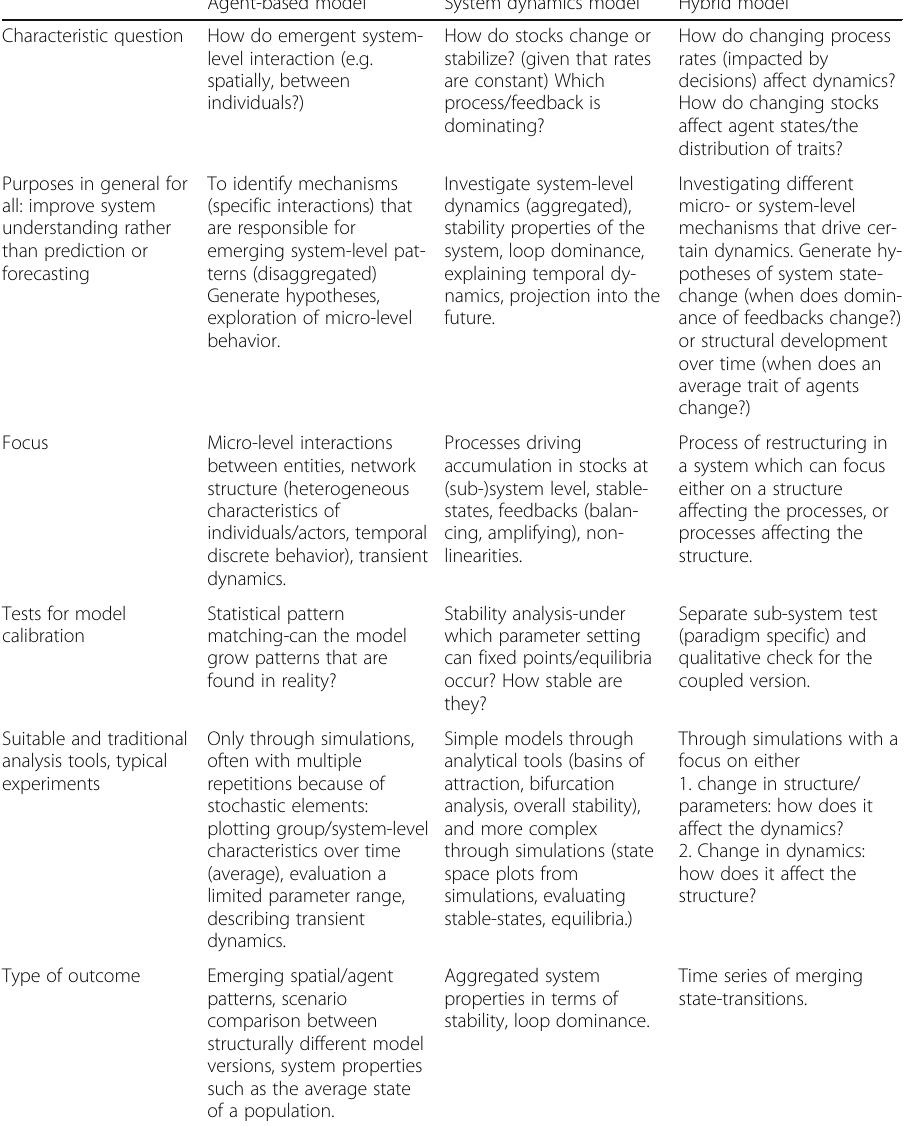
Table 7 Characteristics of agent-based and system dynamics models, and a hybrid model (Martin and Schlüter 2015) Agent-based model System dynamics model Hybrid